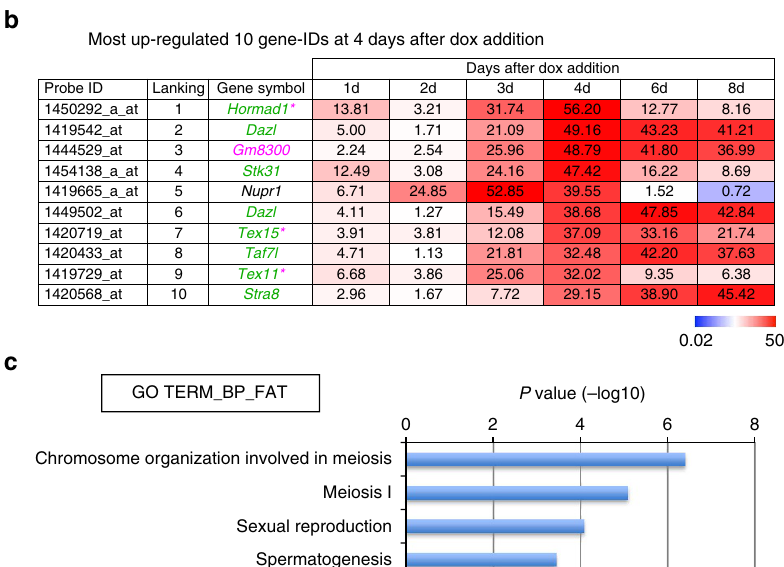
Figure 1 | Elevation of germ cell- and two-cell embryo-related genes in ESCs subjected to Max expression ablation. ( a ) Scatter plots of DNA microarray data from untreated and Dox-treated Max -null ESCs for 4 days using our previously deposited DNA microarray data under accession number GSE27881. Among genes with highly elevated expression in Dox-treated Max -null ESCs compared with that in untreated control cells (eightfold or higher), genes related to germ cells (green) and/or two-cell embryos denoted by Macfarlan et al. 18 (pink) are highlighted. Genes belonging to both categories are green with pink asterisks added to the gene names. ( b ) List of probe identifications (IDs) that showed the most conspicuous upregulation (top 10) in Max -null ESCs treated with Dox for 4 days (4d) and their expression changes during Max expression ablation in ESCs. Dazl is duplicated with different probe IDs. ( c ) GO analyses of genes showing more than eightfold higher expression in Dox-treated Max -null ESCs using DAVID software. The P value cutoff was set to o 1 (cid:2) 10 (cid:3) 3